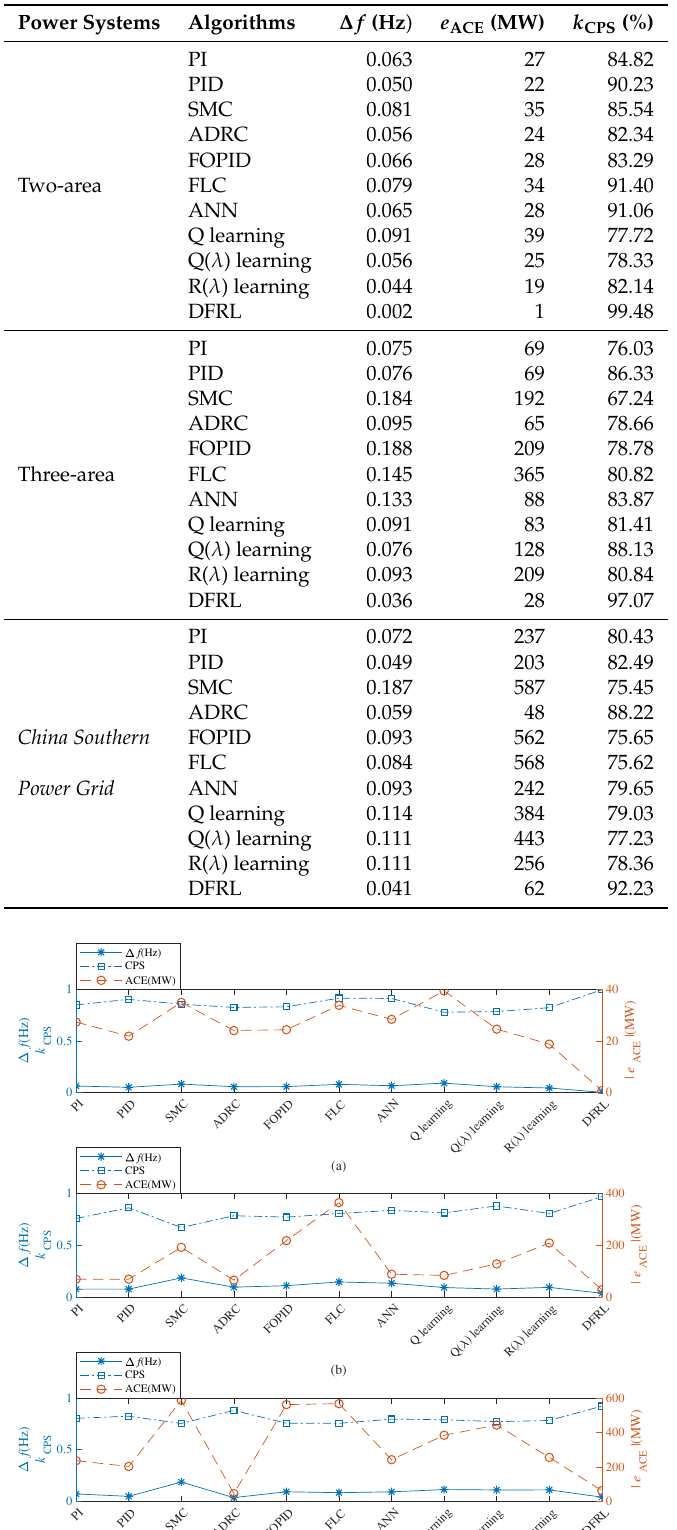
Table 2. Statistic simulation results.